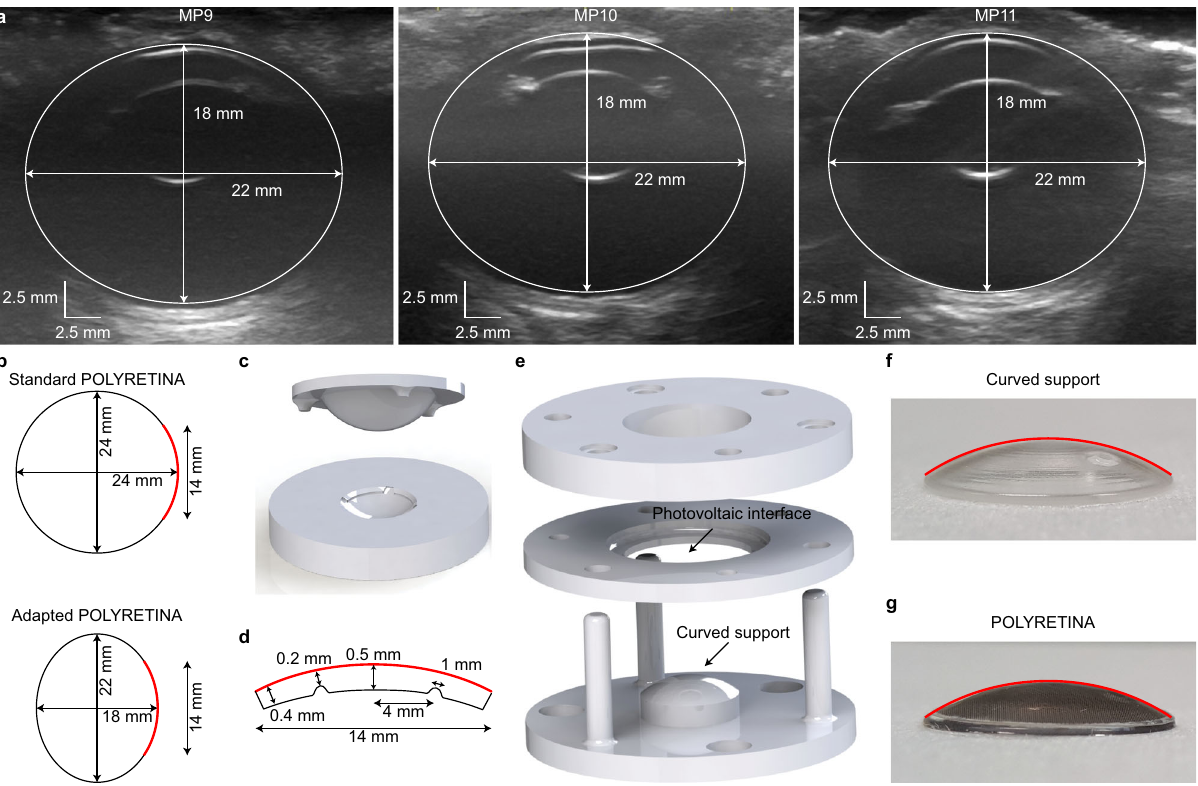
Fig. 5 Adaptation of POLYRETINA to the eye of Göttingen minipigs. a Echography of three minipig eyes. Images are from MP9 – 11. b Axial view of the standard POLYRETINA (top) and the POLYRETINA adapted to the ellipsoidal eye of Göttingen minipigs. The POLYRETINA is identi fi ed by the red line in both sketches. The black circle is the standard human eye (24 mm), and the black ellipse is the eye of Göttingen minipigs. c Three-dimensional model of the parts in poly(methyl methacrylate) used to produce the curved support by cast moulding. d Sketch of the cross-section of the curved support adapted to the minipig eye. The red lines correspond to the red line in b . The curved support has two indentations of 0.5 mm to identify the locations for the retinal tacks. e Three-dimensional model of the bonding setup. f , g Picture of the curved support ( f ) and the POLYRETINA ( g ) with the curvature of the curved support highlighted in red, showing that the curvature is not altered after